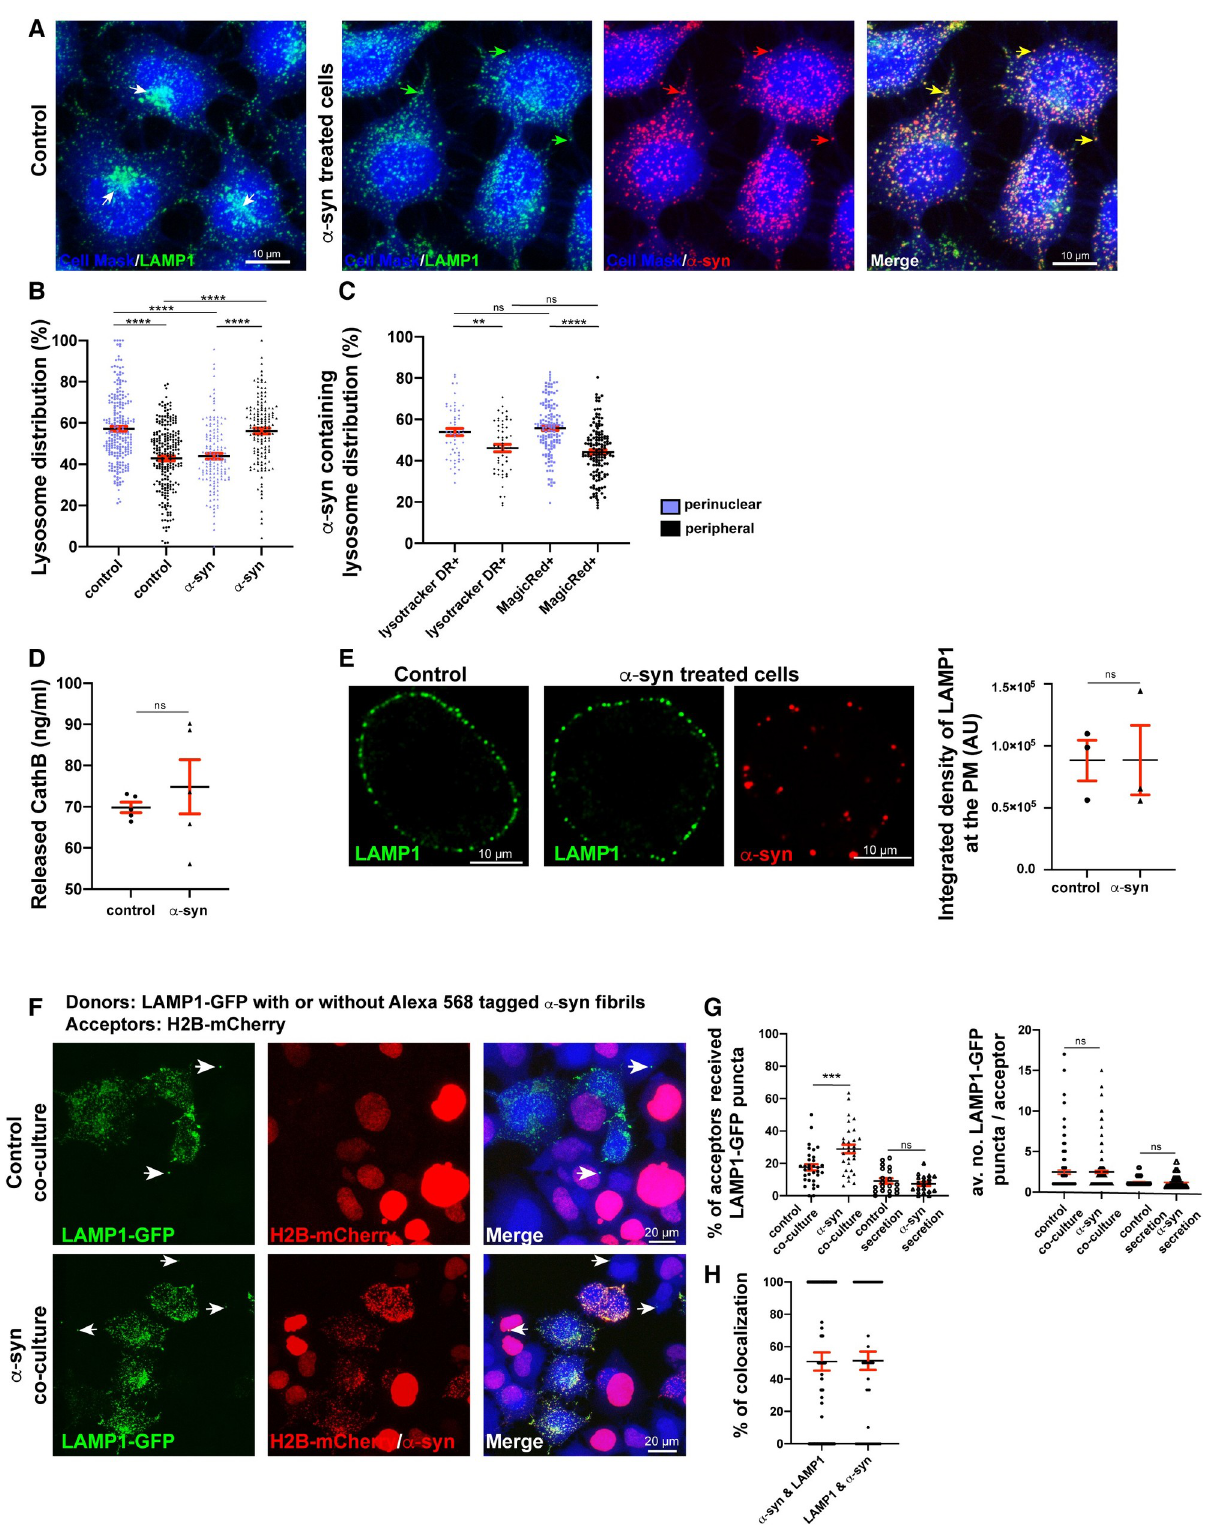
Fig 5. α -Syn–loaded lysosomes localize to the cell periphery, are less functional, and are preferentially transferred to neighboring cells. (A) Representative confocal images of control and Alexa 568–tagged α -syn fibril-treated CAD cells (18 hours) labeled for LAMP1-Alexa 488 antibody,